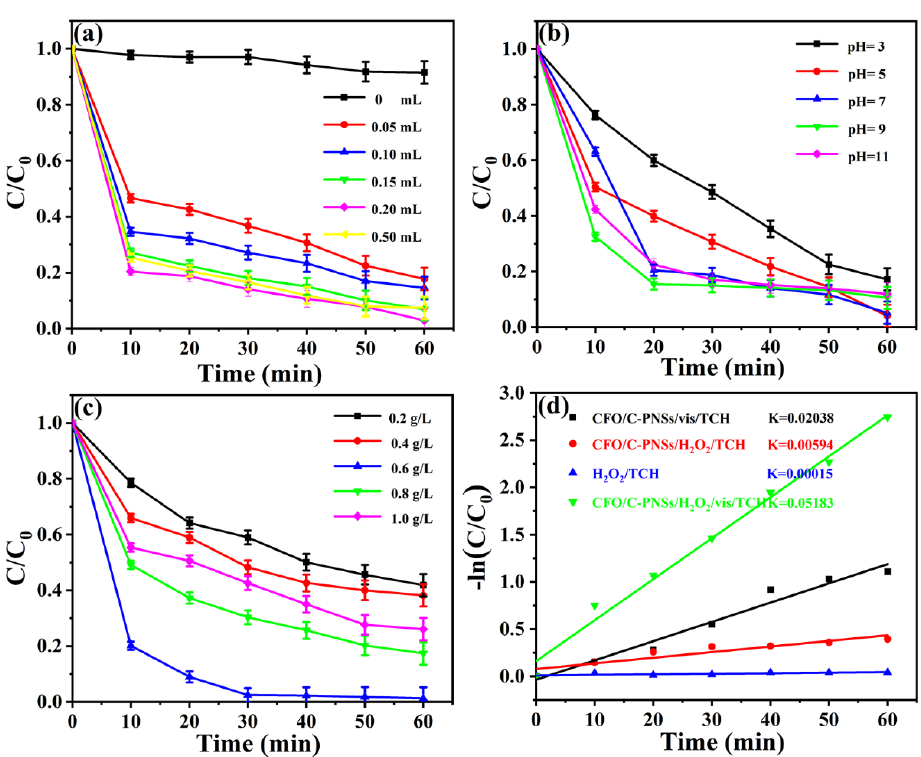
Figure 9. ( a ) Photocatalytic degradation of TCH by the CFO/C-PNS samples with different volumes of H 2 O 2 and ( b ) different values of pH (the amount of H 2 O 2 : 200 μL); ( c ) photocatalytic degradation of TCH with different CFO/C-PNS contents (the amount of H 2 O 2 : 200 μL); ( d ) reaction rate constant k of photocatalytic degradation of TCH with different conditions under visible-light irradiation.